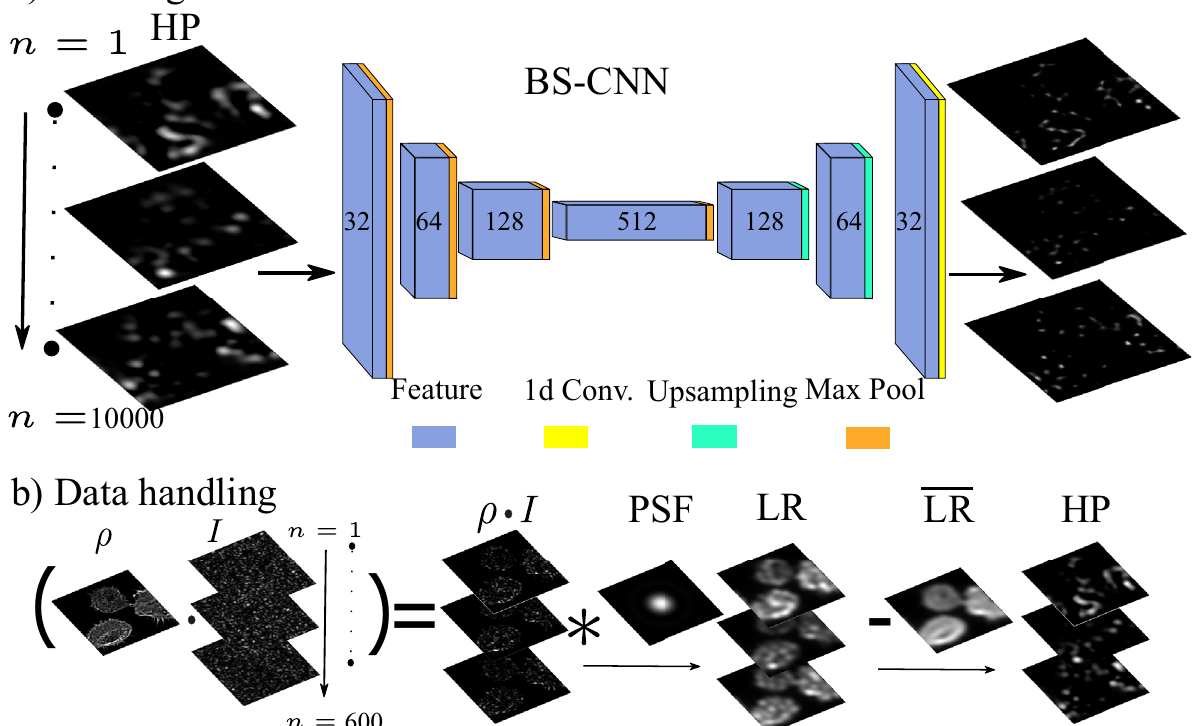
Figure 1. BS-CNN scheme: ( a ) We train the CNN with HP frames so that each illumination and each fluorescent density appears only once and minimizes the loss by comparing with the corresponding ρ · I image. The BS-CNN architecture: for the encoder-decoder architecture we use two-dimensional convolutional layers of size 3 × 3 followed by an element-wise ReLU non-linearity. The feature number is first increased (encoder) by a factor of two from 32 to 512 while the image size is decreased by a 4 × 4 max pool layer. Then the opposite procedure is applied (decoder) up to the original image size. Finally, a one-dimensional convolutional layer is applied to produce a single-channel image. ( b ) Data handling: a ground truth ρ neuron image is selected from an open microscopy repository 25 ; the ground truth image is illuminated 600 times by different speckle realizations I , producing 600 high-frequency images; we convolve with an Airy disk Point spread function (PSF) of resolution η times bigger than the speckle correlation size and obtain 600 low-resolution frames corresponding to the same GT. By subtracting the low-resolution mean LR from each low-resolution frame LR and keeping only the high positive part we obtain the HP